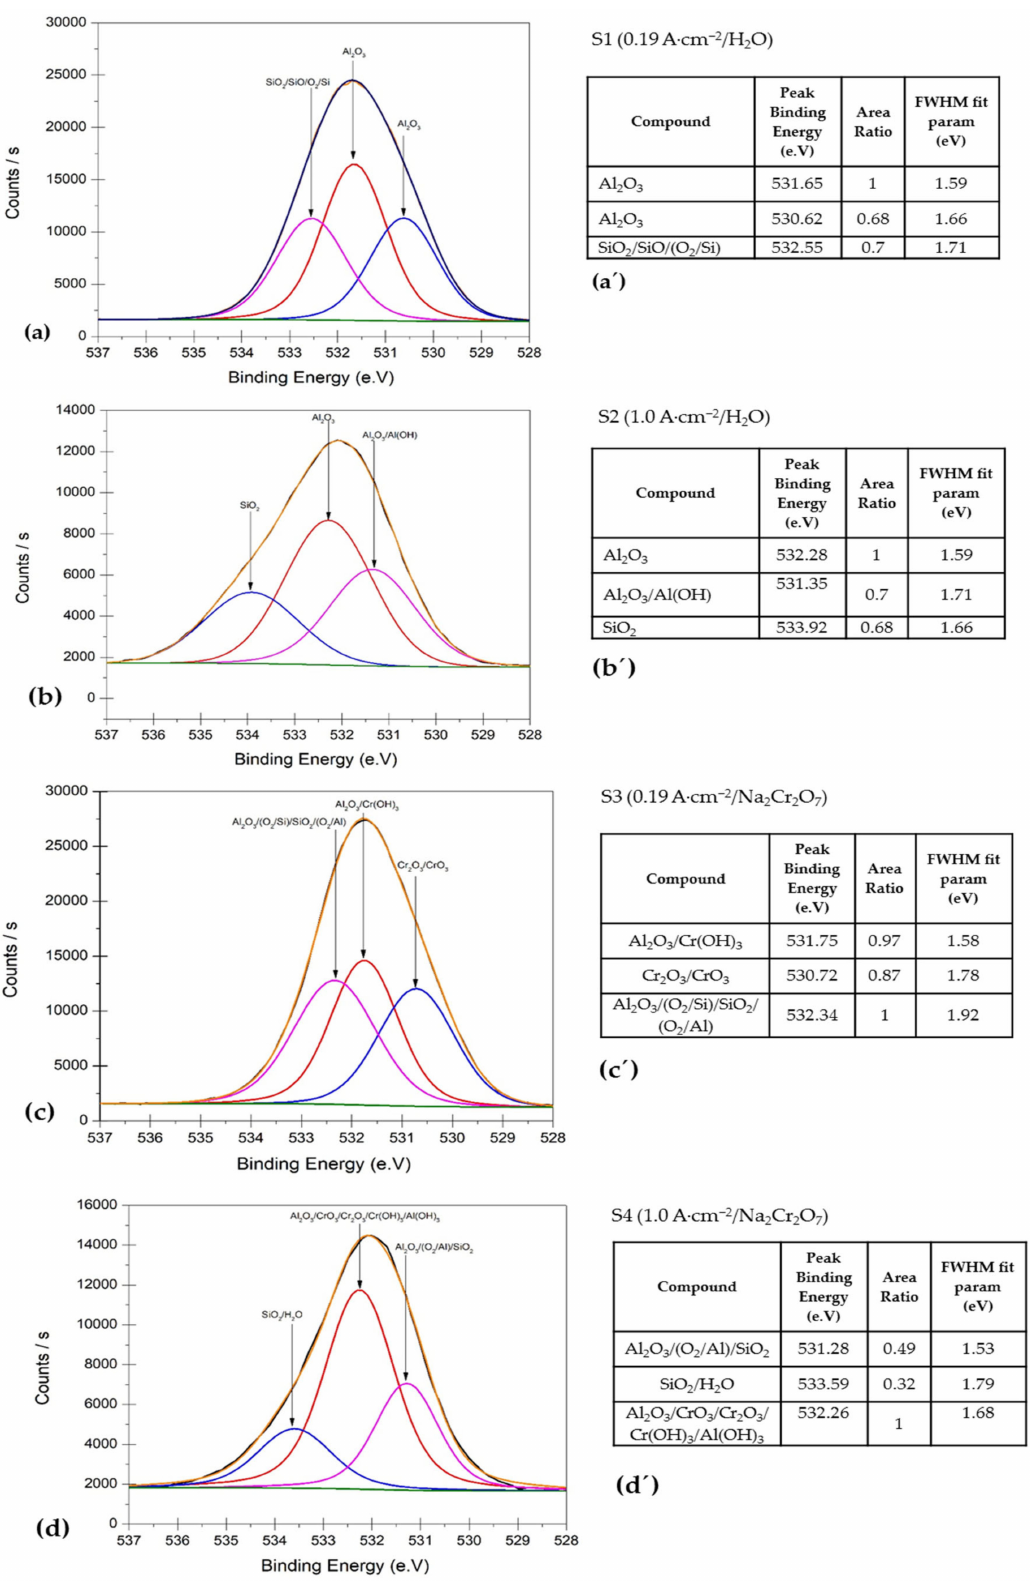
Figure 6. X-ray photoelectron spectra for Al-Li AA2055 alloy anodized: ( a ) O 1s /S1, ( b ) O 1s/S2, ( c ) O 1s/S3, ( d ) O 1s/S4. Parameters obtained from the peak binding energy and (FWHM) fitting ( a’ ) S1, ( b’ ) S2, ( c’ ) S3, ( d’ )